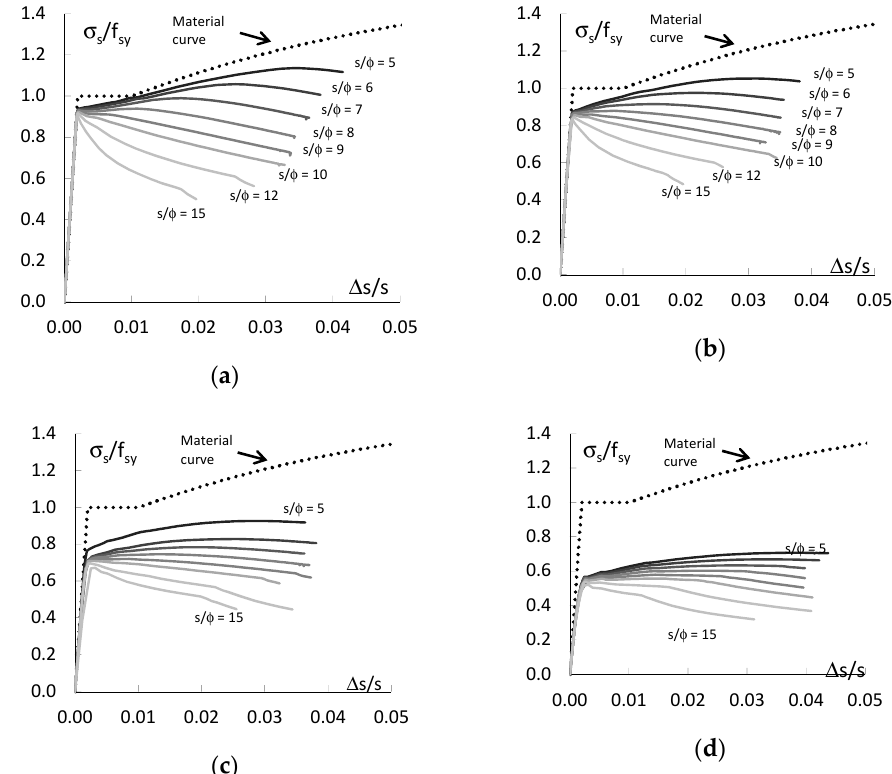
Figure 6. Normalized stress—strain curve for ND bars: ( a ) e/ ϕ = 0.05, ( b ) e/ ϕ =0.10, ( c ) e/ ϕ = 0.25 and ( d ) e/ ϕ = 0.50.